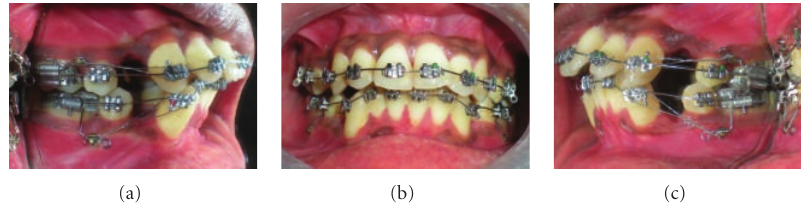
Figure 8: (a, b, c) Miniscrews were placed between roots of 1st molar and 2nd premolar at keratinized gingiva in maxilla and at mucogingival junction in mandible; canine retractions were done only initially and shortly to decrowd the incisors.